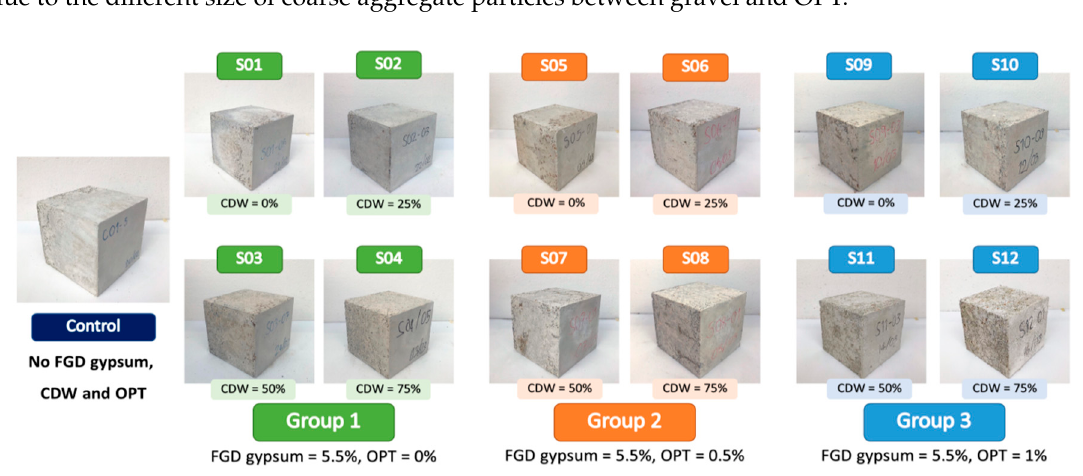
Figure 3. Microstructures of ( a ) OPC; ( b ) FGD gypsum; ( c ) coarse sand; ( d ) CDW; ( e ) gravel; and ( f ) OPT.